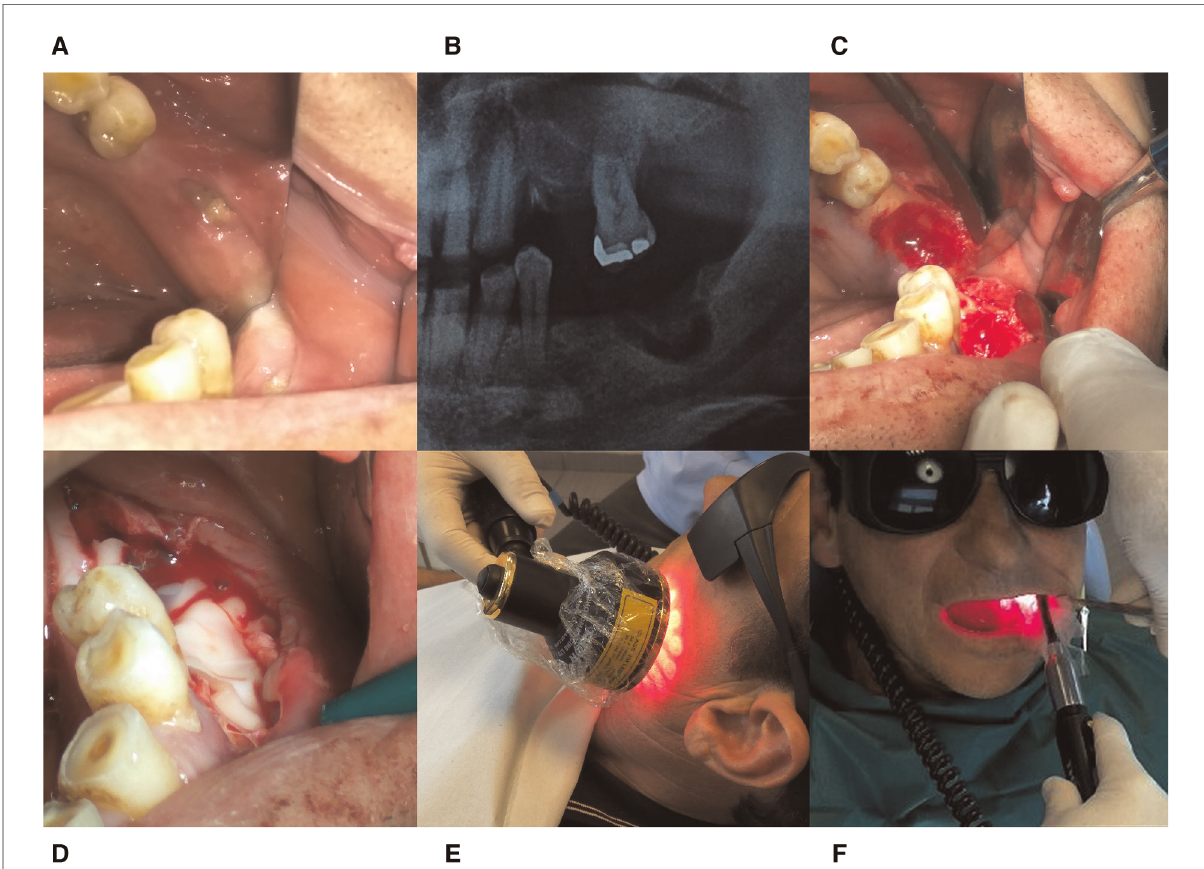
FIGURE 3 Treatment protocol for case 2. ( A ) Intraoral image taken at the patient ’ s initial visit. ( B ) Radiographic Image before operation. ( C ) The surgical area after debridement with piezotome. ( D ) PRF- membrane placement into the socket. ( E ) Extraoral PBM therapy with 69 LED Cluster 660/850 nm. ( F ) Intraoral PBM therapy with Laser 660 and 810 nm